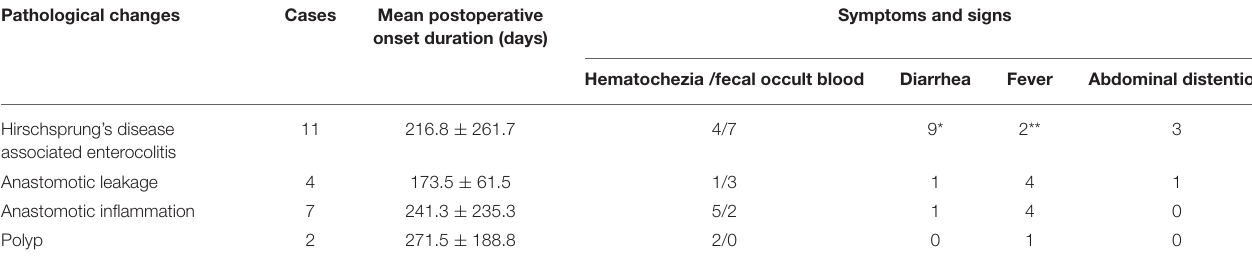
TABLE 1 | Overview of pathology, symptoms, and signs. Pathological changes